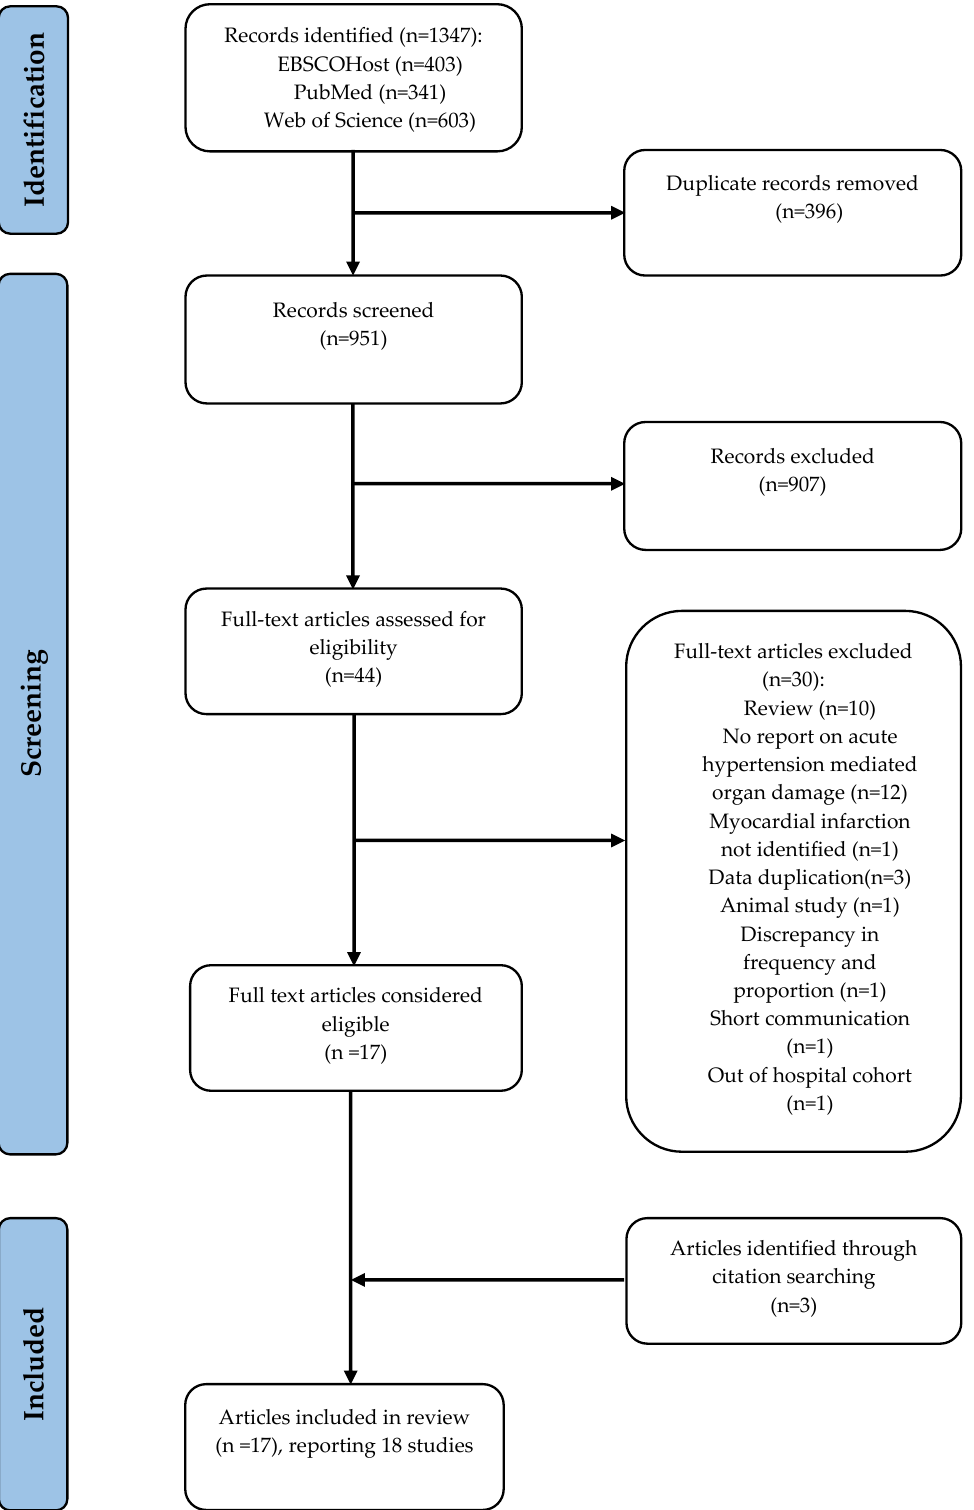
Figure 1. Flow diagram showing a summary of the search strategy. One article reported 2 studies, resulting in a composite of 18